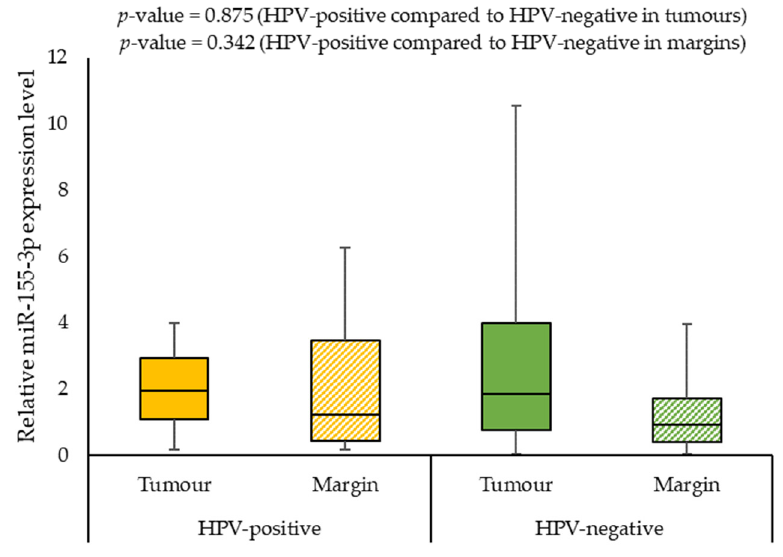
Int. J. Mol. Sci. 2023 , 24 , x FOR PEER REVIEW Figure 6. The relative expression level of miR-155-3p in HPV-positive compared to HPV-negative patients.